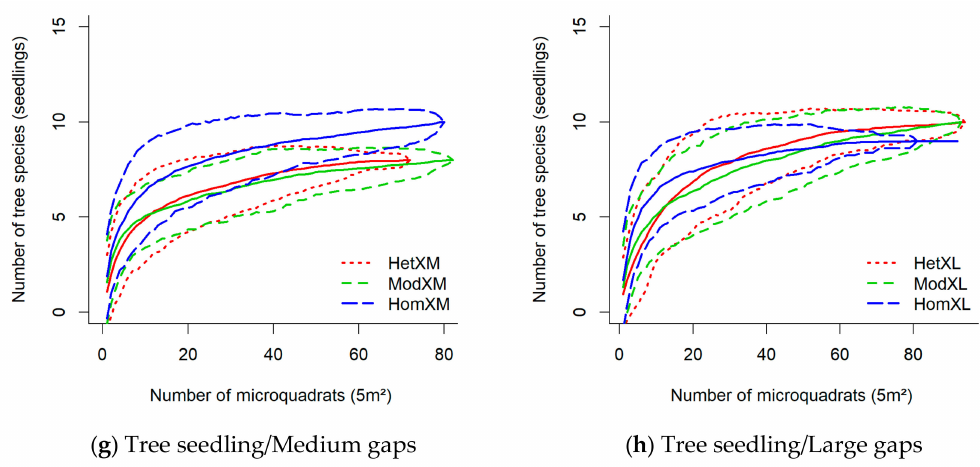
Figure 5. Species accumulation curves from landscapes with di ff erent spatial heterogeneity levels (heterogeneous (Het), moderate (Mod), homogenous (Hom)) in four distinct gap / forest environments (forest (F) understory, small (S) gaps, medium (M) gaps, large (L) gaps) for shrub ( a )–( d ) and tree seedling ( e )–( h ) species. Envelopes show boot-strapped 95% confidence